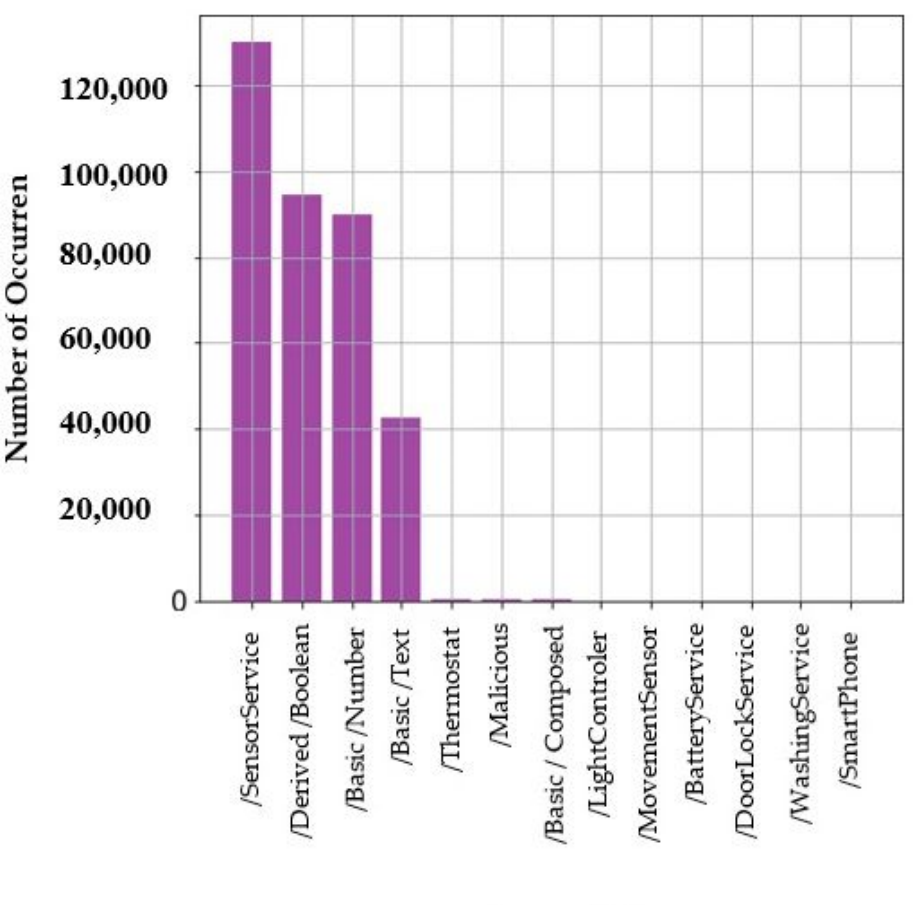
Figure 7. “Normality” column distribution.